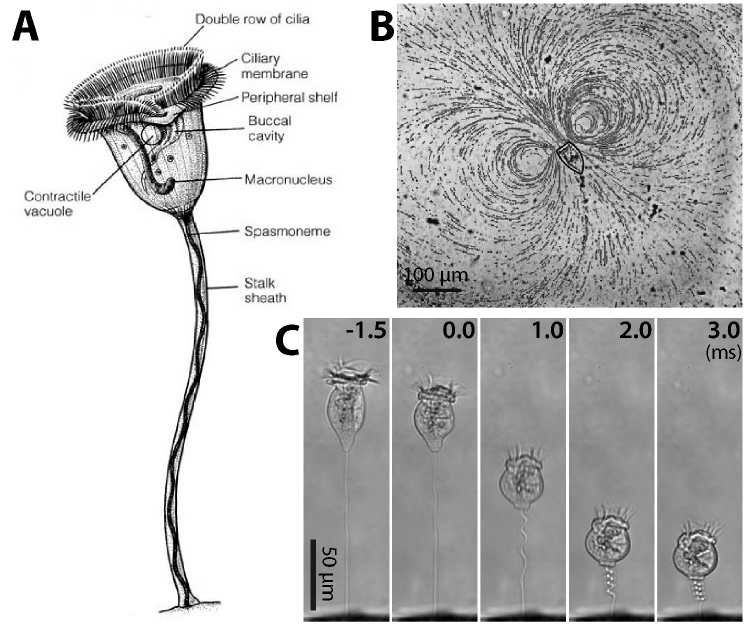
Figure 1. Sessile ciliate protozoan Vorticella . ( A ) Structure of Vorticella convallaria (reproduced from [7]); ( B ) pathlines of water flow generated by cilia beating of V. convallaria (reproduced from [8]); ( C ) sequential images of stalk contraction of V. convallaria (reproduced from [9]). The stalk begins to coil at 0 ms.